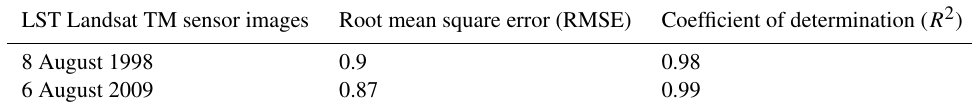
Table 8. Accuracy assessment of land surface temperature derived from Landsat TM sensor data using calculation RMSE and R 2 . LST Landsat TM sensor images